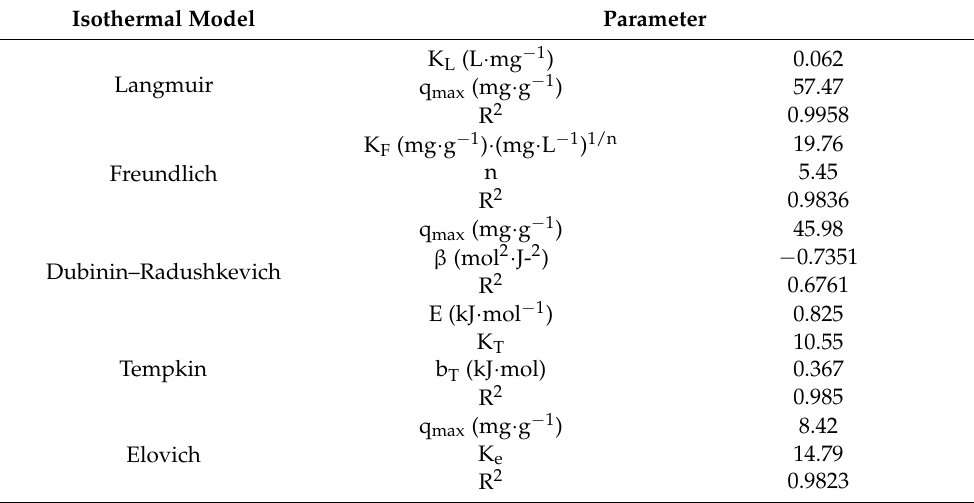
Figure 11. ( A ) The dependence of q̅ on ln C cb ̅̅̅̅ according to the Tempkin model and ( B ) The de- pendence of ln ( q̅ / C cb ̅̅̅̅ ) on q̅ according to the Elovich isotherm adsorption model. Table 5. Values of constants of Langmuir, Freundlich, Dubinin–Radushkevich, Tempkin, Elovich adsorption models for